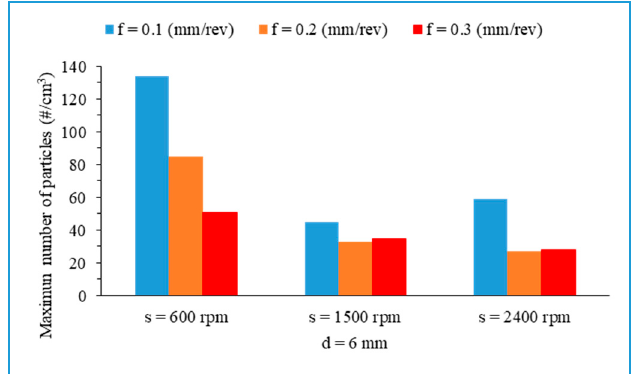
Figure 16. Peak value of number of fine particles related to particle size.